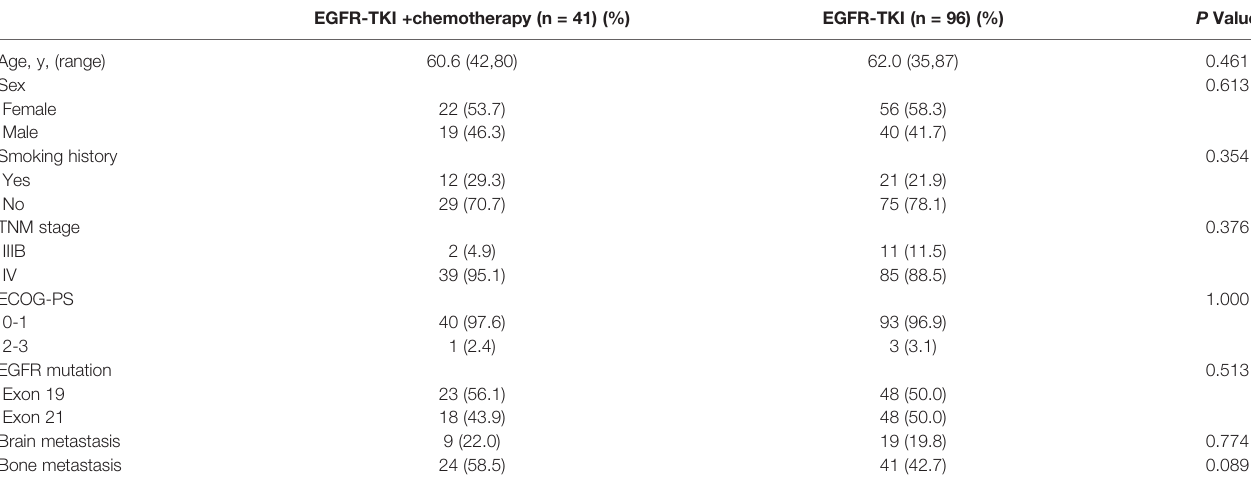
TABLE 1 | Patients baseline characteristics.